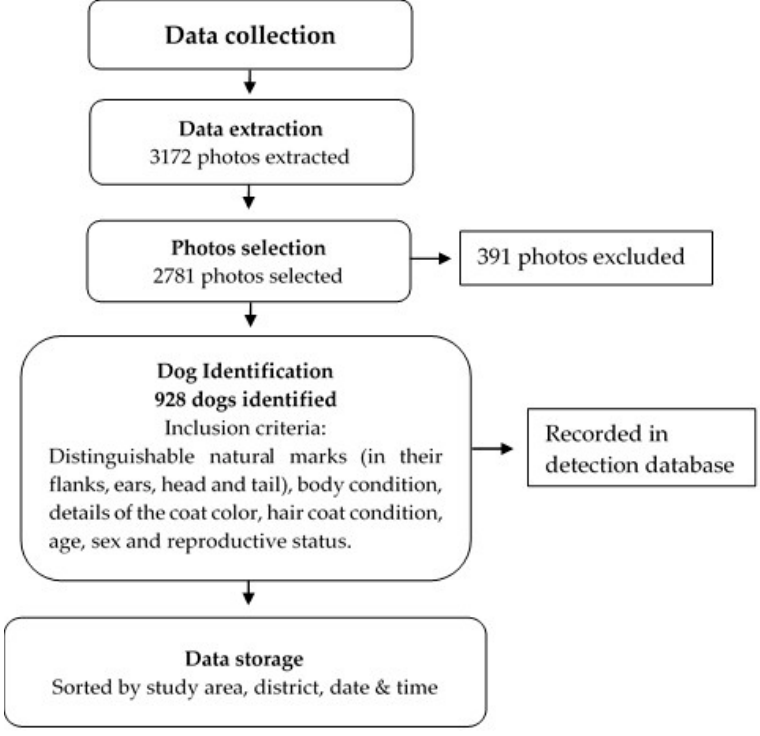
Figure 2. Flowchart of the data collection through field survey using PSR method. 391 photos were excluded due to poor quality and duplication.